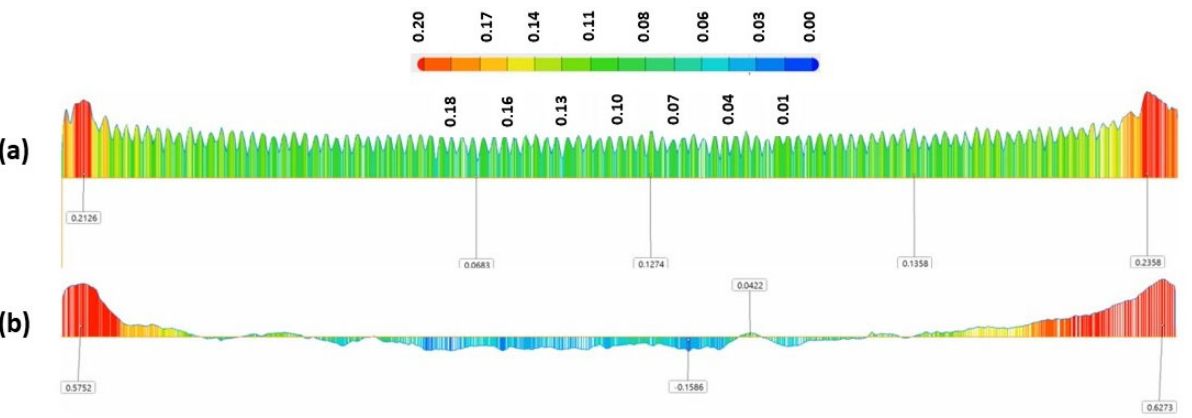
Figure 9. Three ‐ dimensional (3D) topography of the specimen before and after the laser polishing: